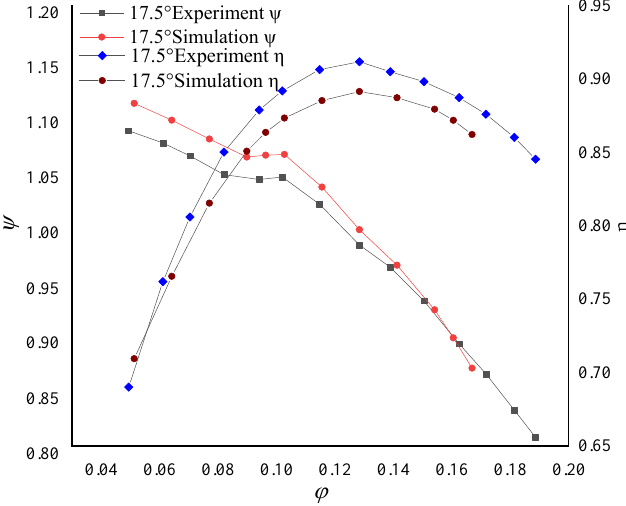
Figure 3. Comparison of performance between simulation and experiment.